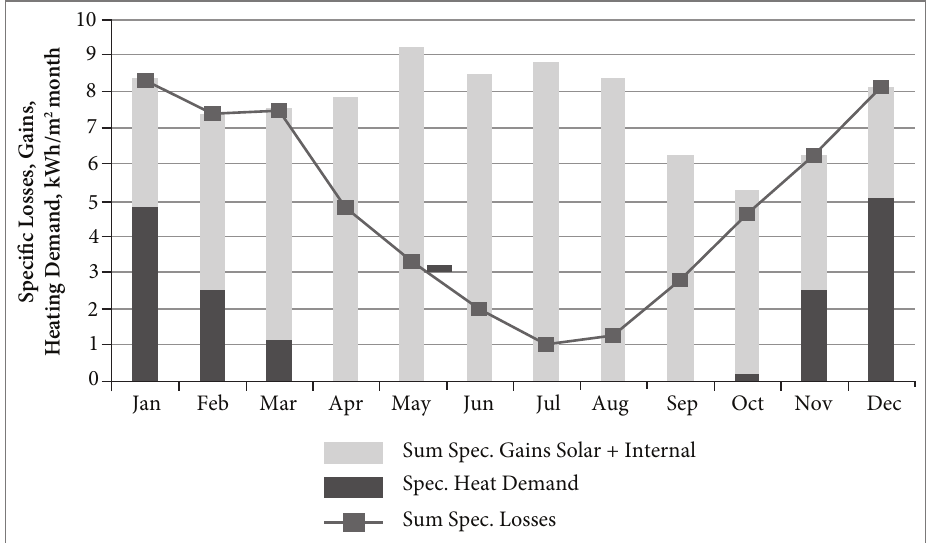
Fig. 7. Annual specific heat